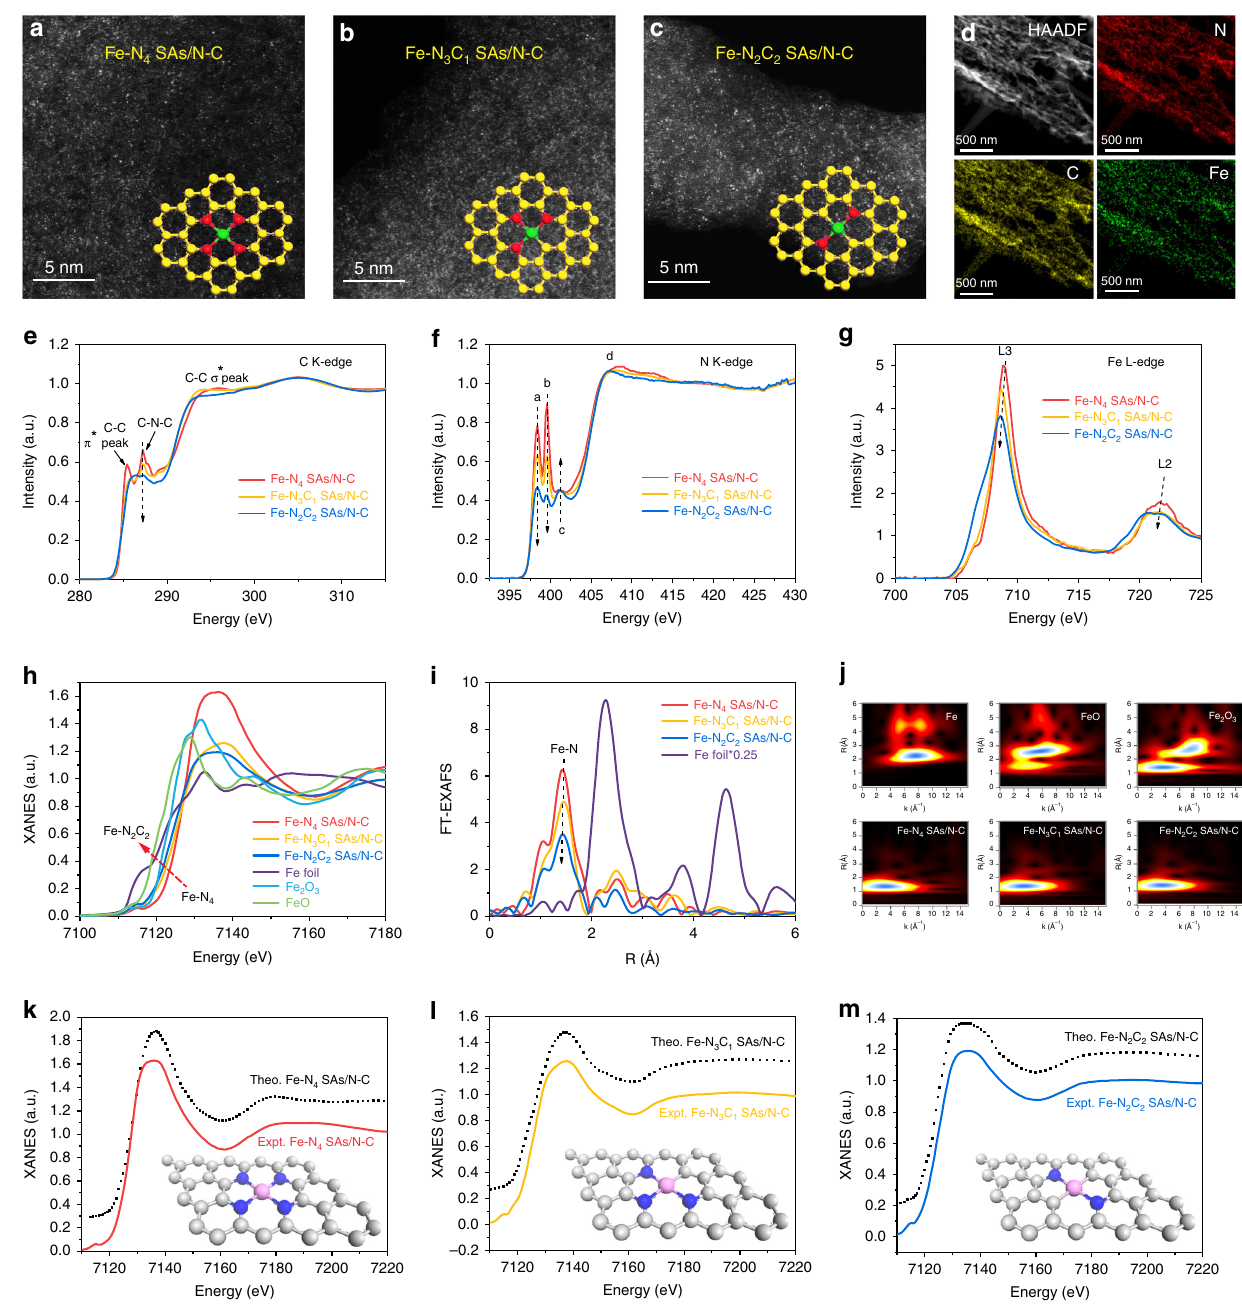
Fig. 2 Structure characterization of Fe-N x C y SAs/N-C. a – c AC-HAADF-STEM images of the as-synthesized a Fe-N 4 SAs/N-C, b Fe-N 3 C 1 SAs/N-C, c Fe- N 2 C 2 SAs/N-C. The insets are the corresponding structure model. The yellow, red and green balls refer to C, N, and Fe atoms, respectively. Scale bar, 5 nm. d HAADF-STEM-EDS mapping of the Fe-N 4 SAs/N-C. Scale bar, 500 nm. e – g XANES spectra at the e C K-edge, f N K-edge, and g Fe L-edge. h XANES spectra at the Fe K-edge of the Fe-N 4 SAs/N-C, Fe-N 3 C 1 SAs/N-C, Fe-N 2 C 2 SAs/N-C, Fe foil, Fe 2 O 3 , FeO. i FT k 3 -weighted χ (k)-function of the EXAFS spectra of the Fe-N 4 SAs/N-C, Fe-N 3 C 1 SAs/N-C, Fe-N 2 C 2 SAs/N-C, and Fe foil. j WT of the Fe K-edge. k – m Comparison between the experimental K-edge XANES spectra and the theoretical spectra of k Fe-N 4 SAs/N-C, l Fe-N 3 C 1 SAs/N-C, m Fe-N 2 C 2 SAs/N-C. The grayish-white, blue and pink balls refer to C, N, and Fe atoms, respectively well with the endothermic peaks in the DSC and a peak at 100 °C SAs/N-C to Fe-N 2 C 2 SAs/N-C. To assess the thermal stability of in the MS curves. The weight loss of ~25 % for Fe-N 4 SAs/N-C the Fe-N 4 SAs/N-C, Fe-N 3 C 1 SAs/N-C, and Fe-N 2 C 2 SAs/N-C catalysts, we carried out the thermogravimetry coupled with mass and Fe-N 3 C 1 SAs/N-C catalysts and ~10% for Fe-N 2 C 2 SAs/N-C catalyst from 100 °C to 800 °C can be attributed to the desorption spectrometry (TG-MS) analysis. Supplementary Fig. 9 show the of adsorbed CO 2 molecules and the decomposition of functional TG-DSC curves and the corresponding MS results ( m/z = 18, 44 groups on carbon surface to form CO 2 , which respectively cor- are assigned to H 2 O and CO 2 , respectively). The weight loss of ~5 % around 100 °C can be attributed to the desorption of H 2 O respond to the two peaks at 250 °C and 550 °C in the MS curves. molecules adsorbed in the Fe-N x C y /N-C catalysts, which matches From the X-ray photoelectron spectroscopy (XPS) analysis of Fe NATURE COMMUNICATIONS| (2019) 10:4290